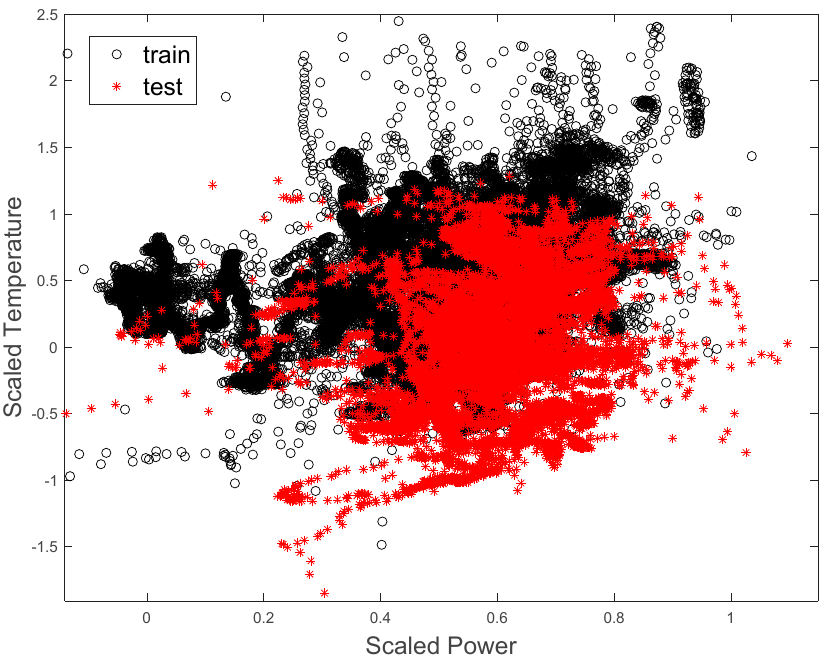
Figure 12. Distribution of training (black ‘o’) and test (red ‘ ∗ ’) data sets.